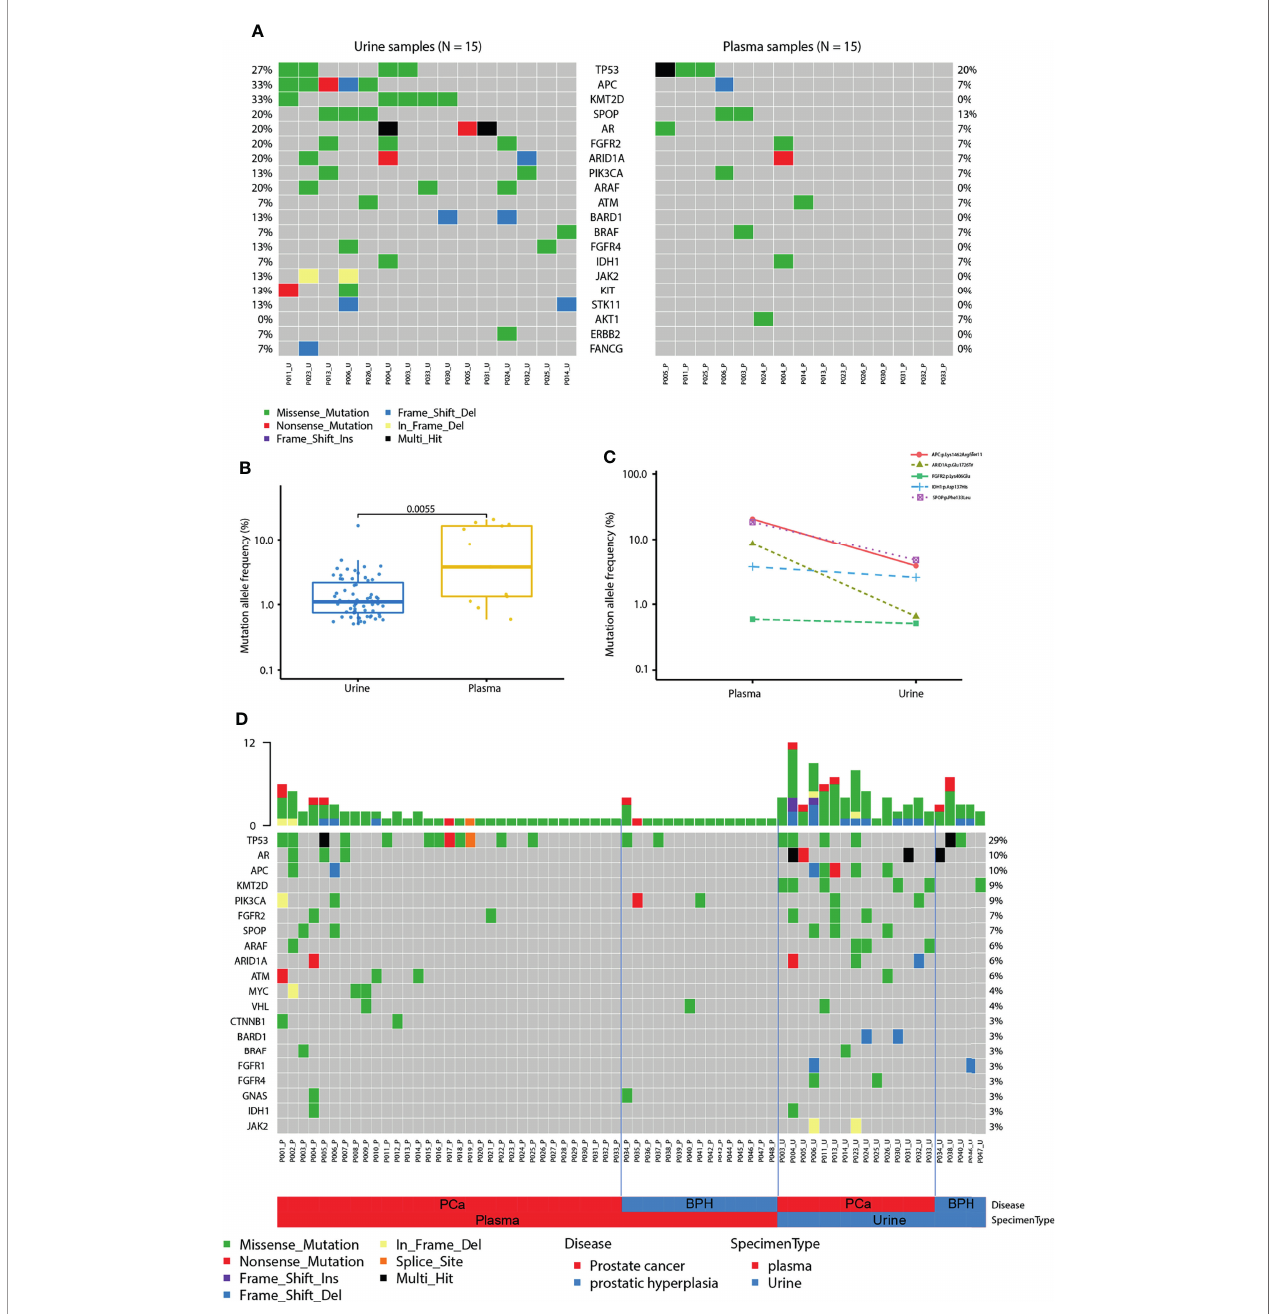
FIGURE 6 | Comparison of cfDNA between urine and plasma. (A) Mutation landscape of urine (left) and plasma (right) samples from patients with prostate cancer. Some genes with only one mutation were not shown in the fi gure. (B) Mutation allele frequencies detected in paired urine and plasma samples from patients with prostate cancer. (C) Mutation allele frequencies of matched mutations detected in paired urine and plasma samples. (D) The landscape of mutations in urine and plasma samples from patients with prostate cancer (PCa) and benign prostatic hyperplasia